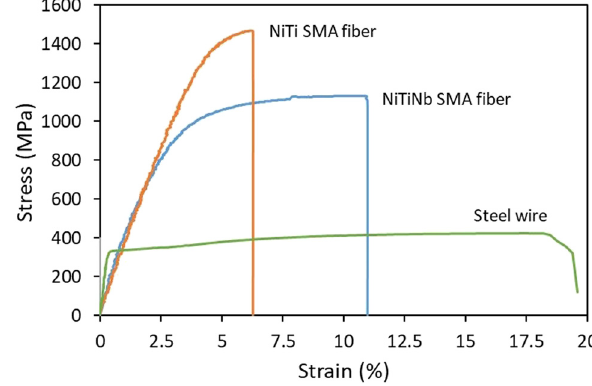
Figure 2: Stress and strain curves of the SMA fi bers and steel